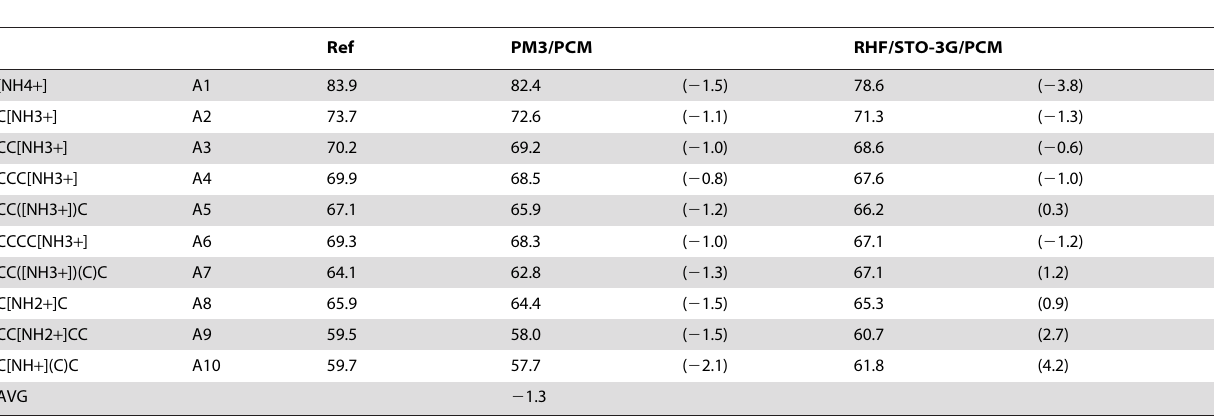
Table 2. Predicted electrostatic solvation free energies of ammonium type molecules.